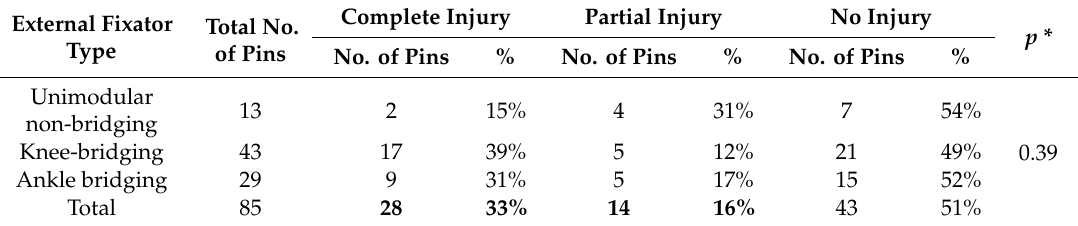
Table 5. The incidence of the TNAC injury via pins applied at the level of the TNAC according to the external fixator